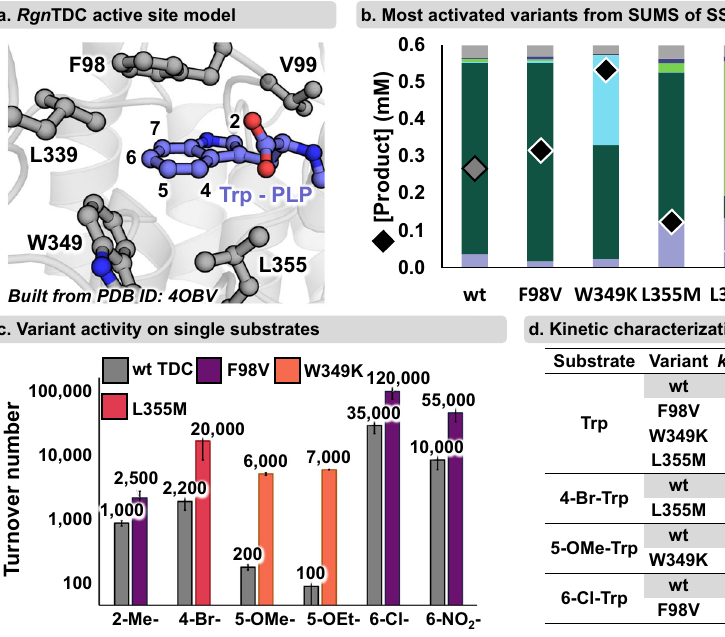
Fig.3|SUMSidenti fi es Rgn TDCactivesitemutationsthatimproveactivityfora range ofsubstrates. a Active site model of Rgn TDC (built from PDB ID: 4OBV) 39 with residues highlighted at which mutations were found that signi fi cantly altered promiscuity or improved activity. b Select improved variants from activesitelibraries.Substratescreeningconditions:0.2mMTrpand7-I-Trp,and 2mM 2-Me-Trp, 4-Br-Trp, 5-OMe-Trp, and 6-Cl-Trp, 4h, 37°C. Colored bars indicate the relative abundances of each product, and black diamonds indicate the total product formed. Full screening results found in Supplementary